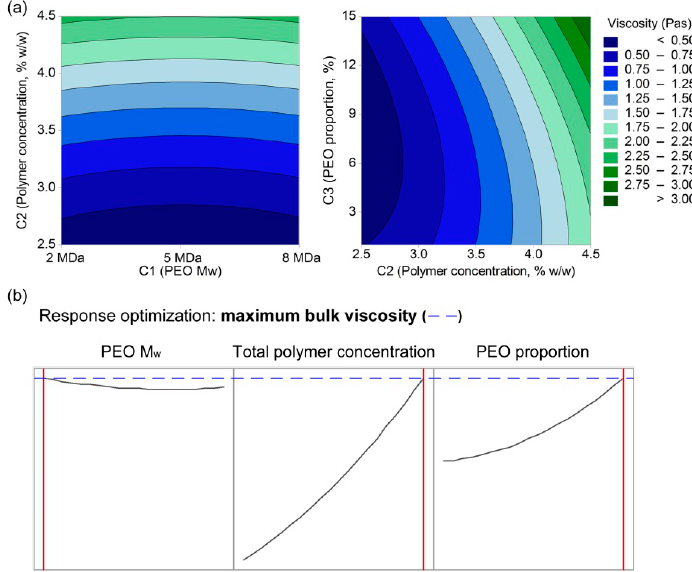
Figure 7. ( a ) contour plots of the polymer-blend solution bulk viscosity as a function of total polymer concentration and PEO M w (left) and total polymer concentration and PEO proportion (right); ( b ) response optimization plots of the polymer-blend solution bulk viscosity as a function of PEO M w , total polymer concentration, and PEO proportion.